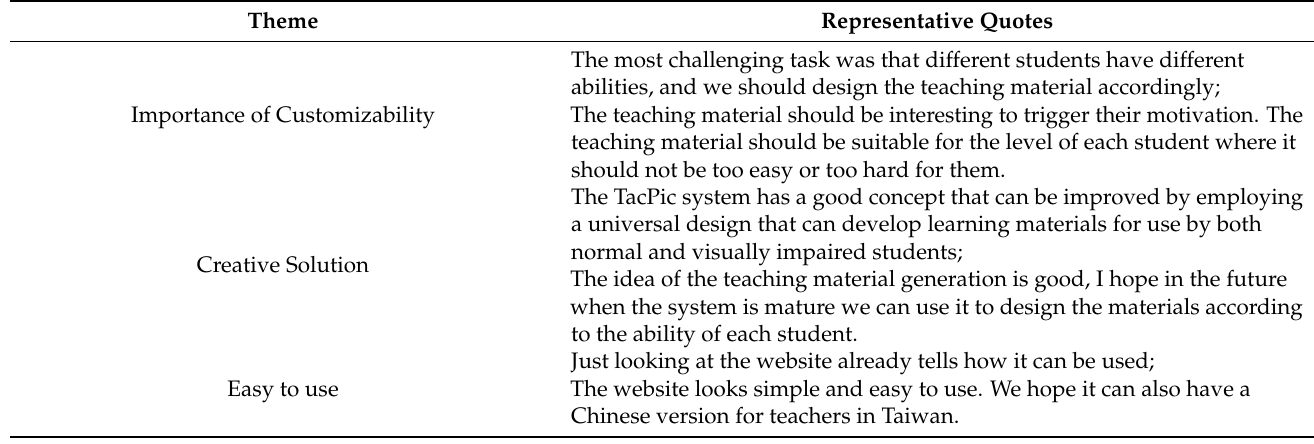
Table 8. Summary of the themes based on the qualitative evaluation of the TacPic system and tactile materials. Theme